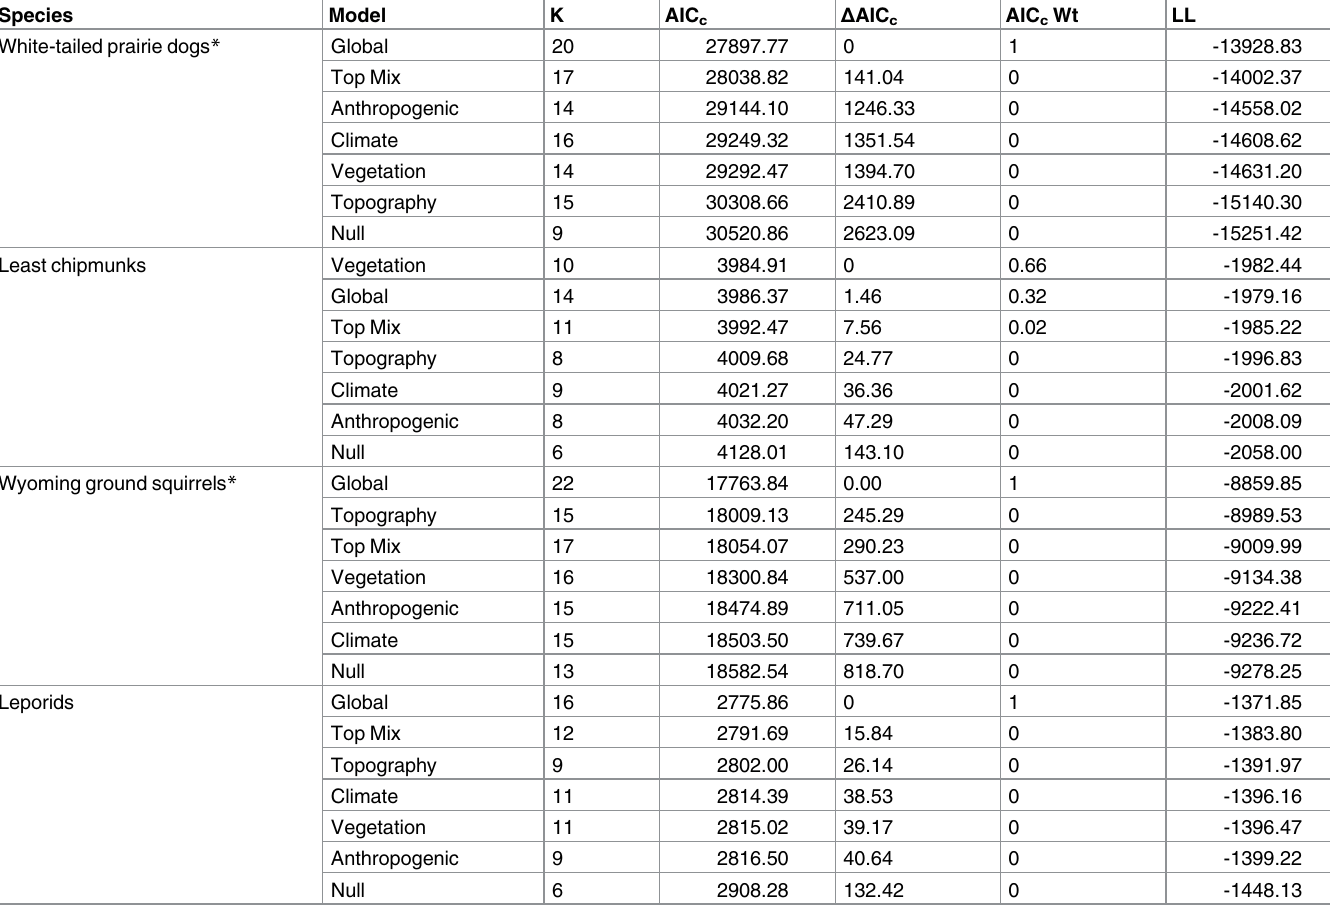
Table 5. Abundance model selection results for small mammal species groups surveyedin the shrub-steppe and grassland regions of Wyoming, 2010–2012. Species White-tailed prairie dogs